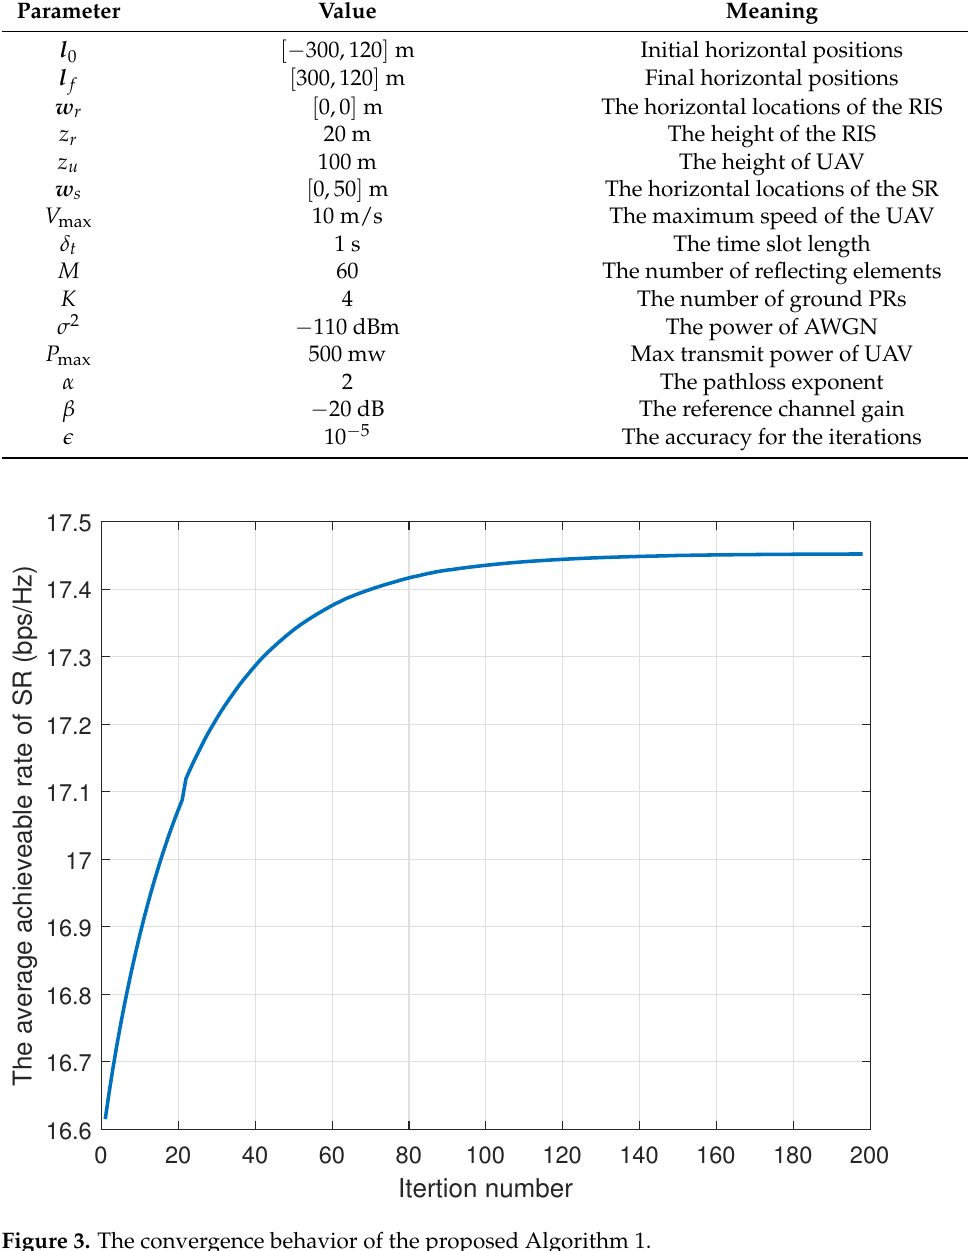
Figure 3. The convergence behavior of the proposed Algorithm